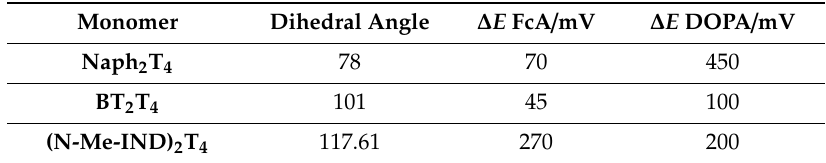
Table 3. Testing potential di ff erences ( ∆ E ) observed for the enantiomers of FcA and DOPA in aqueous solution with 0.05 M HCl as the supporting electrolyte on GC modified with enantiopure oligo- Naph 2 T 4